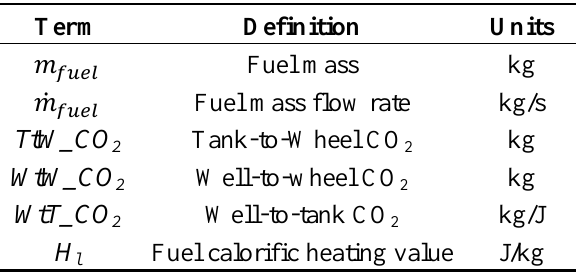
Table 2. Terms used for fuel tank